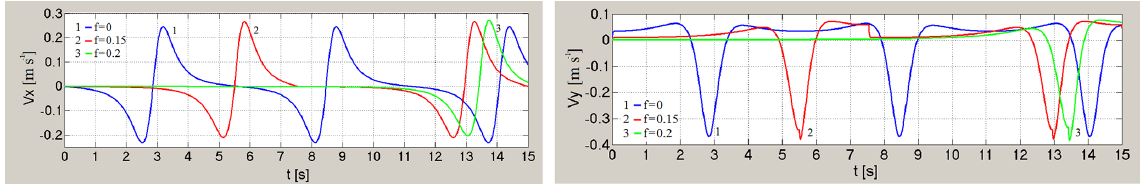
Figure 20. Graphs of velocity projections V x ( t ) and Vy ( t ) of point C at different values of the coefficient of sliding friction f are different and for coefficient of rotational friction k = 0 and for load mass is M = 500kg.